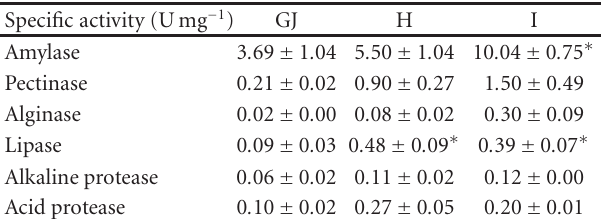
Table 2: Specific activities of amylase, pectinase, alginase, lipase, alkaline protease, and acid protease (Umg − 1 ) in the gastric juice (GJ), hepatopancreas (H), and intestine (I) of juvenile Cherax albidus . Data are reported asmeans ± SEM. For each enzyme, n = 5. Asterisks represent statistically significant values ( P < . 05) along the digestive tract within each enzyme.